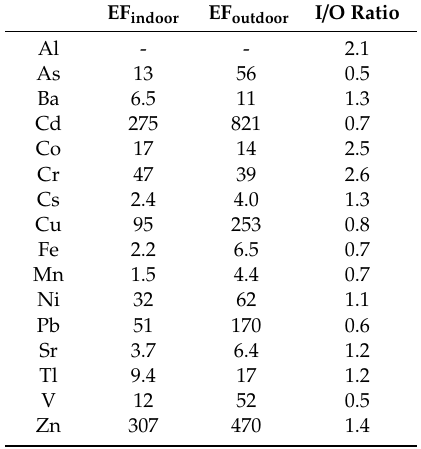
Table 6. Enrichment factors (EFs) and indoor to outdoor concentration ratios (I / O) for the trace metals